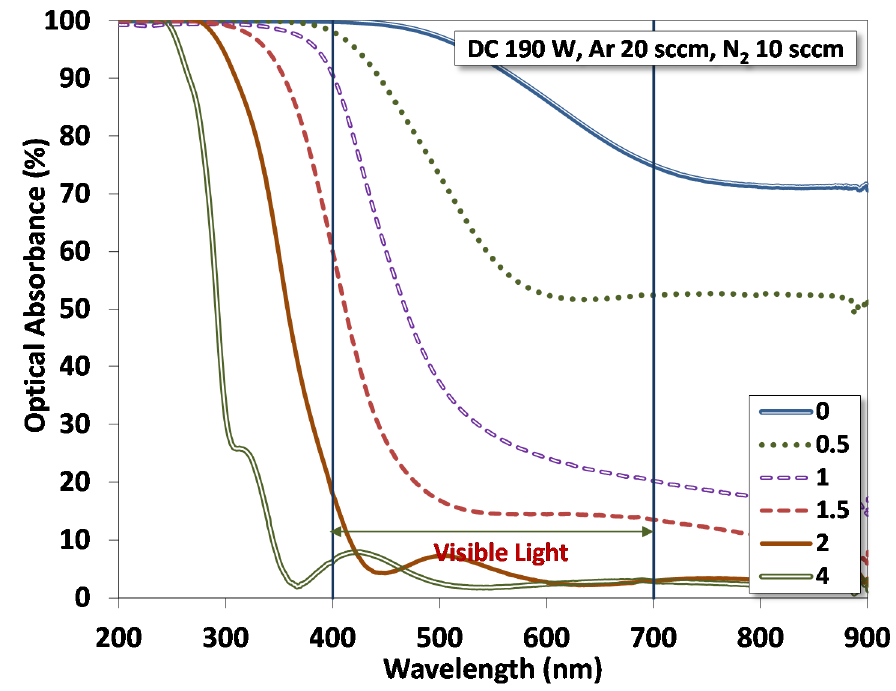
Figure 7. UV-Visible-NIR absorbance spectra of annealed films under different oxygen flow rates.